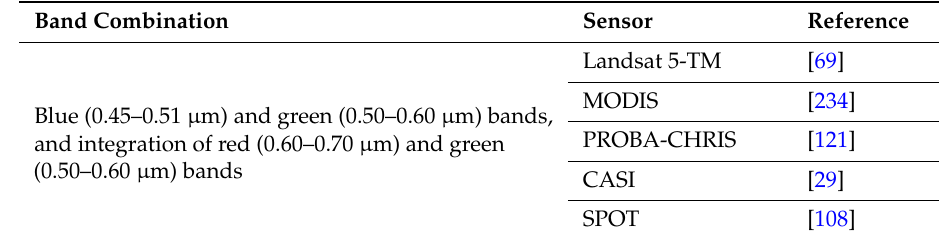
Table 9. Remotely measurements of total phosphorus (TP) using various sensors and blue and green bands, and integration of red and green bands